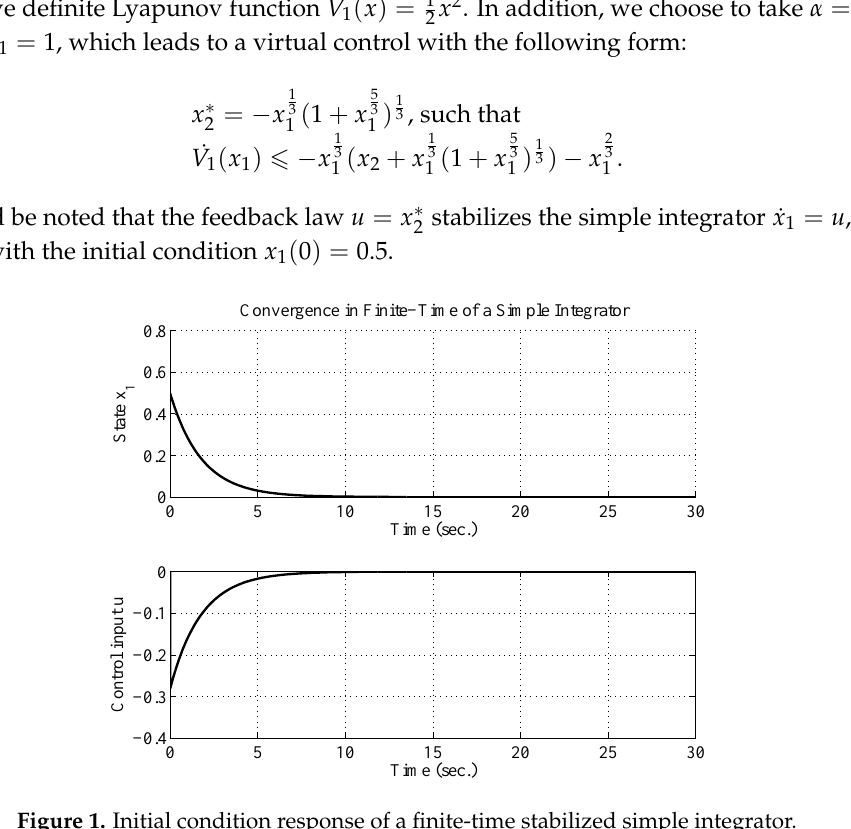
Figure 1. Initial condition response of a finite-time stabilized simple